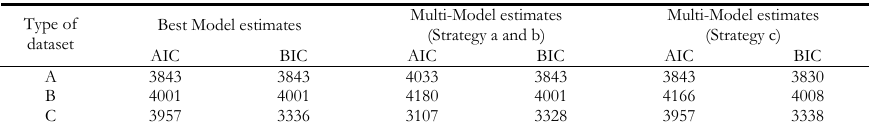
Estimated population size by the optimal model and the Multi-Model technique according to AIC and BIC selection index Multi-Model estimates Type of Best Model estimates Multi-Model estimates (Strategy a and b) (Strategy c)